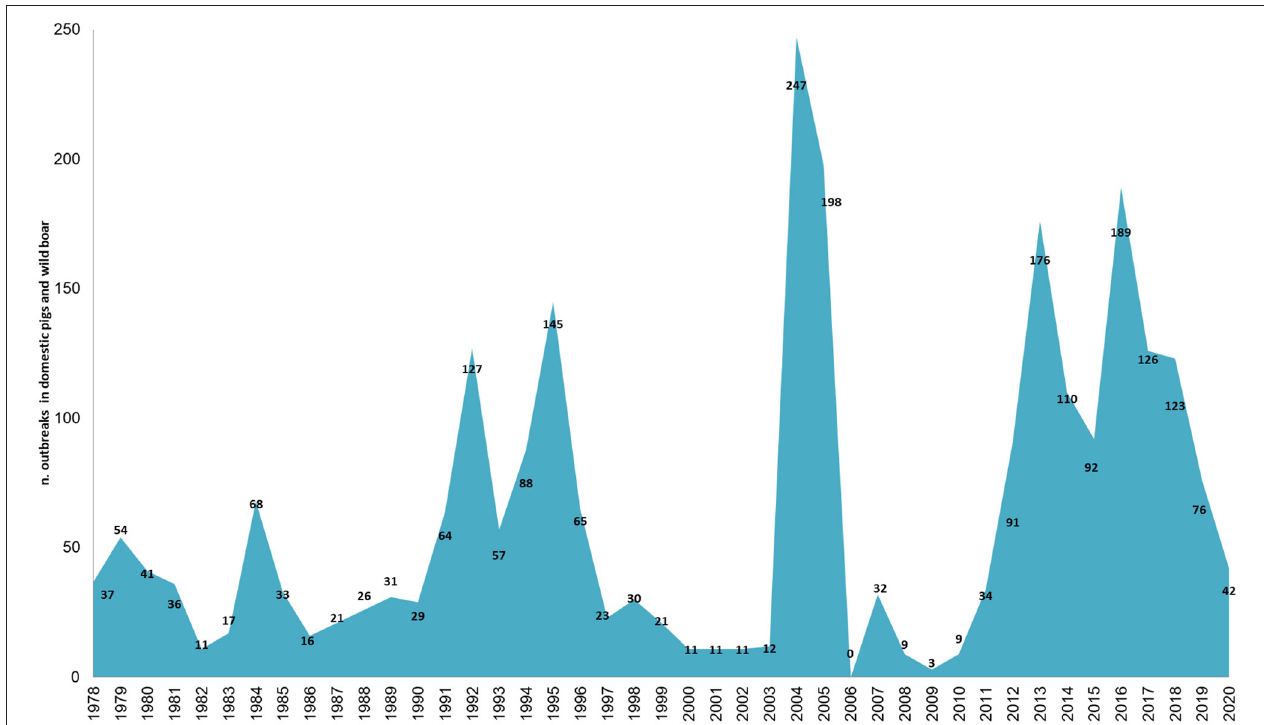
FIGURE 2 | Number of African swine fever cases (i.e., outbreaks in domestic pig farms or in illegal free-ranging pigs, and cases in wild boar) reported in Sardinia from 1978 (by suspicion data on SIMAN) to 2020. The last notified outbreak in domestic pig farms occurred in September 2018. From April 2019, ASF outbreaks are limited to seropositive wild